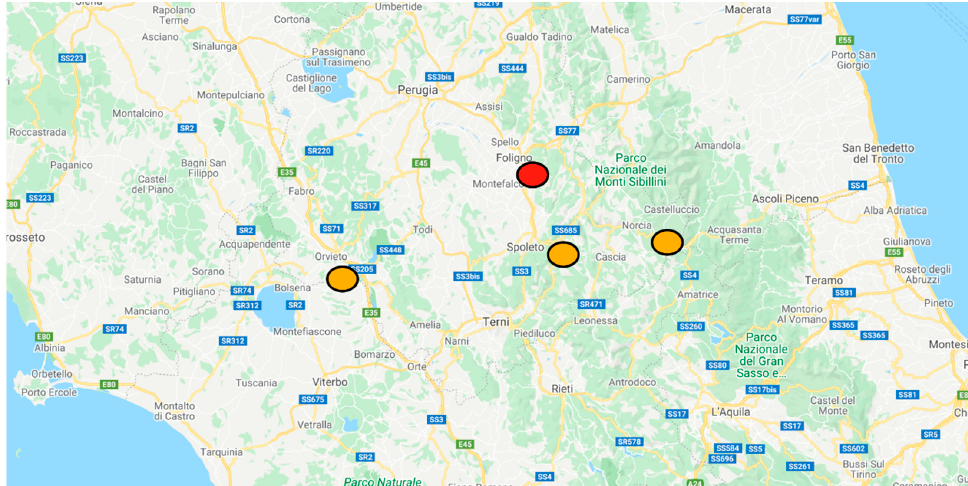
Figure 1. Geographical catchment area, and location of hospitals in USL Umbria 2 area, Adapted and modified from google maps. In red the hub hospital of Foligno, in orange to the left the spoke of Orvieto, in the middle Spoleto and to the right Norcia. https://www.google.it/maps/search/ ospedali/@42.9888504,12.6977109,10z/data=!3m1!4b1 last access 5 December 2021.